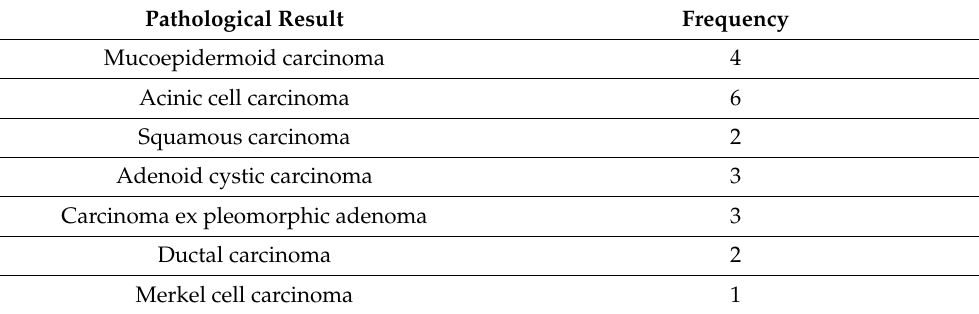
Table 2. Overview of malignant parotid lesions.